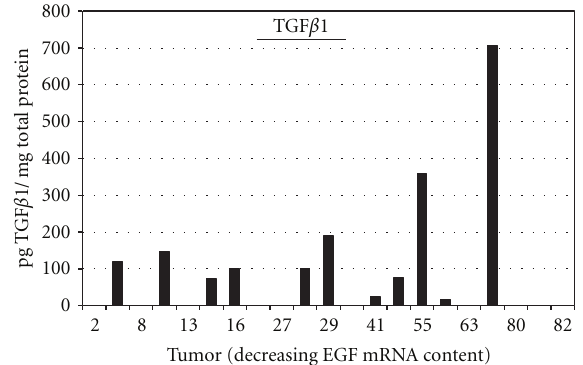
Figure 5: Distribution of TGF β 1 protein in 21 sarcomas within the 82-sarcoma cohort. The line labeled TGFbeta1 overlays the tumors within which TGF β 1 significantly predicted Fas mRNA content.